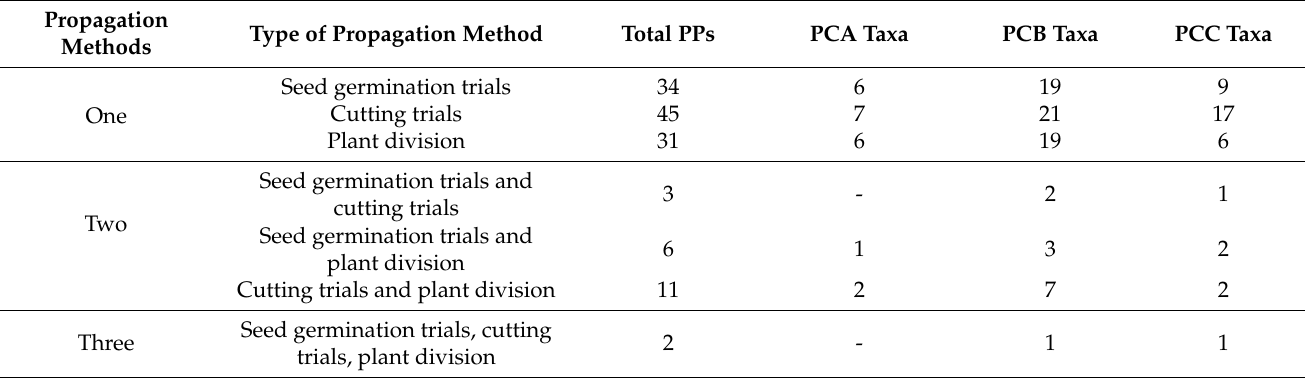
Table 2. Overview of different propagation methods (or combinations thereof) used for the priority plants (PPs) of different categories (PCA, Threatened and Near Threatened; PCB, Local Balkan endemics and subendemics; PCC, Regionally rare and/or uncommon plants) planted in awareness- raising sites.